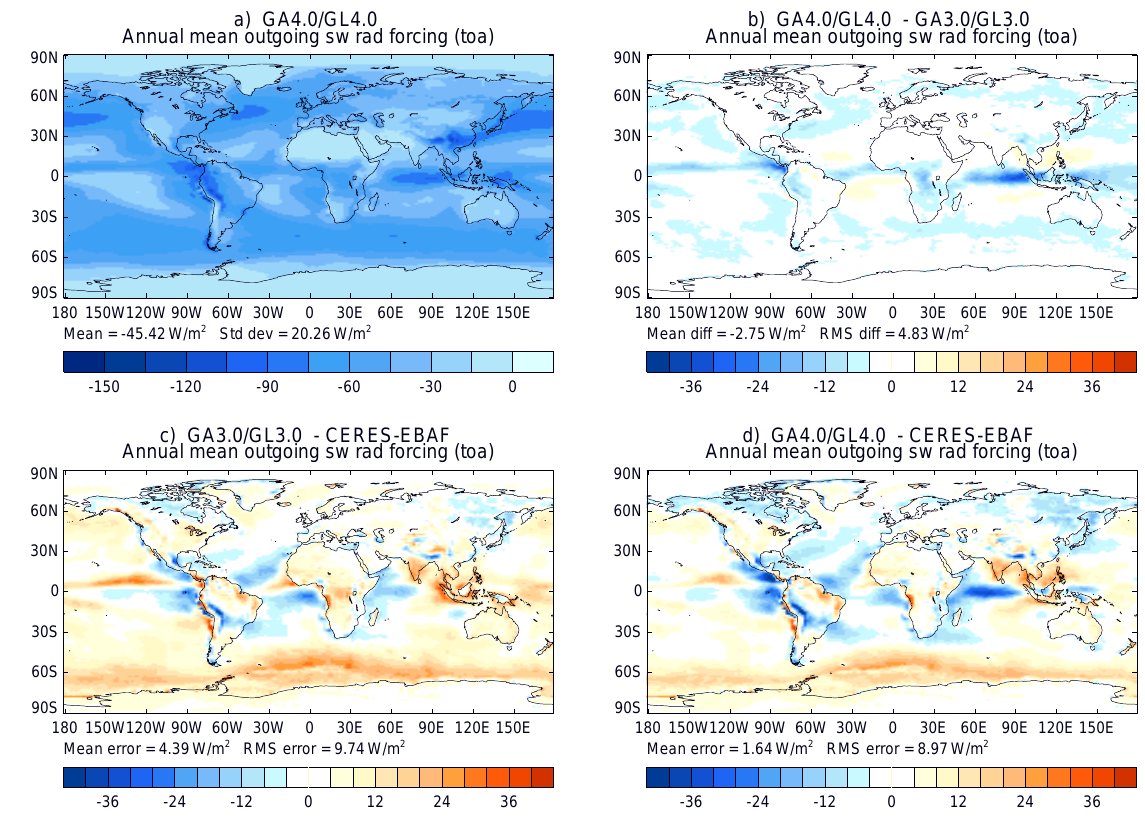
Fig. 11. Annual mean shortwave cloud forcing from N96-AL_clim using the same format as Fig. 7. The validating data set is from the CERES-EBAF climatology (Loeb et al., 2009).